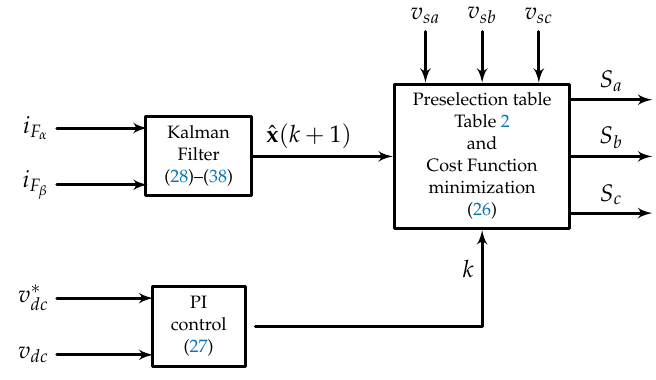
Figure 2. Proposed control system.